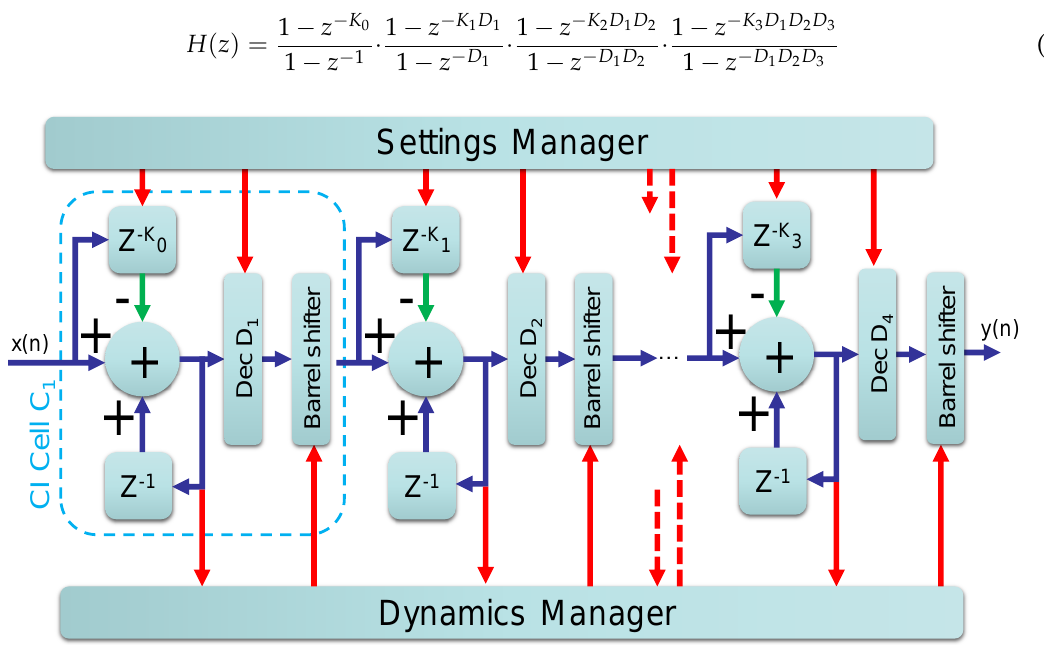
Figure 4. Modified CIC architecture based on Combo-Integrator sections interconnected by a barrel-shifter and a decimator. A dynamics manager monitors the dynamics in output of every section and operates the barrel-shifters.